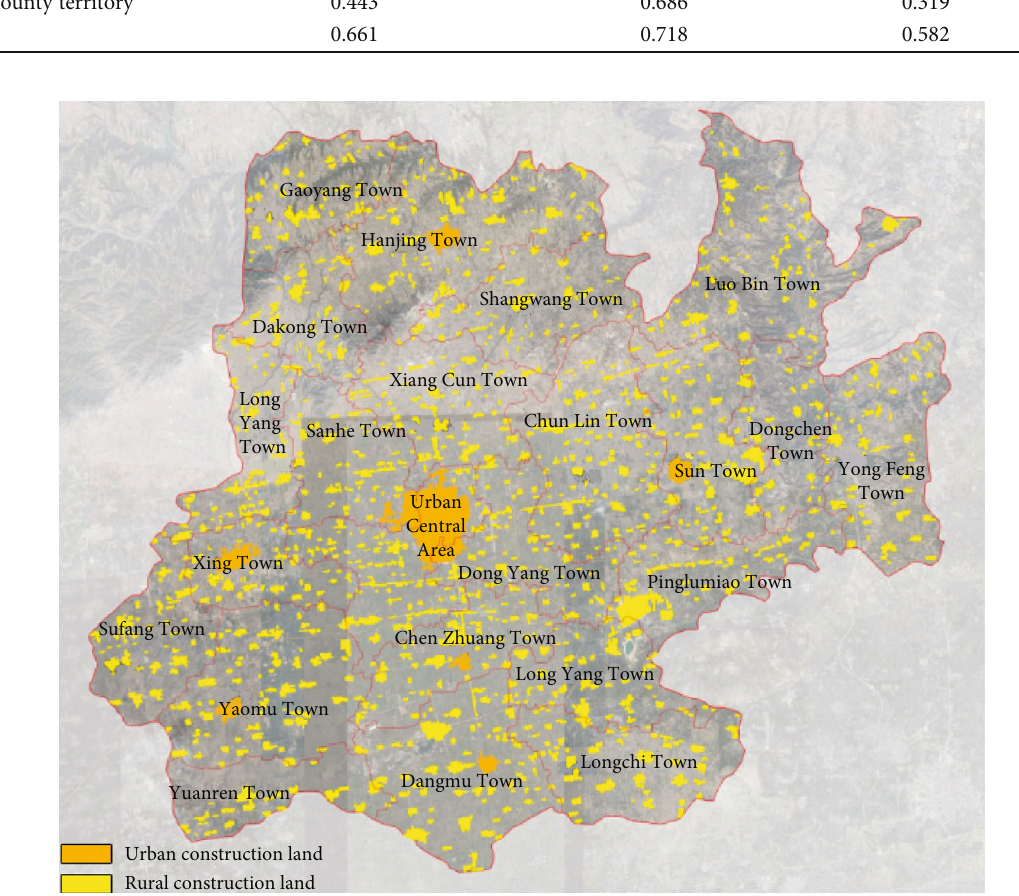
Figure 1: A map of urban and rural construction land in Pucheng in